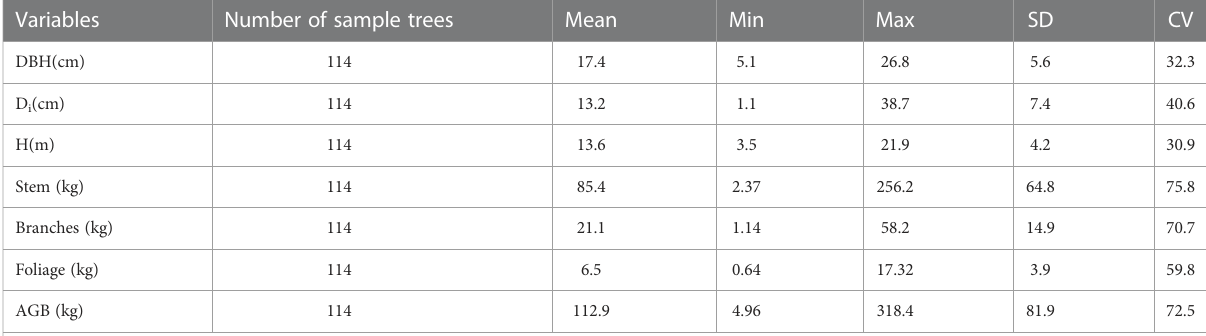
TABLE 1 Summary statistics of tree variable measurements for the Larix principis-rupprechtii plantation biomass dataset in the study area.